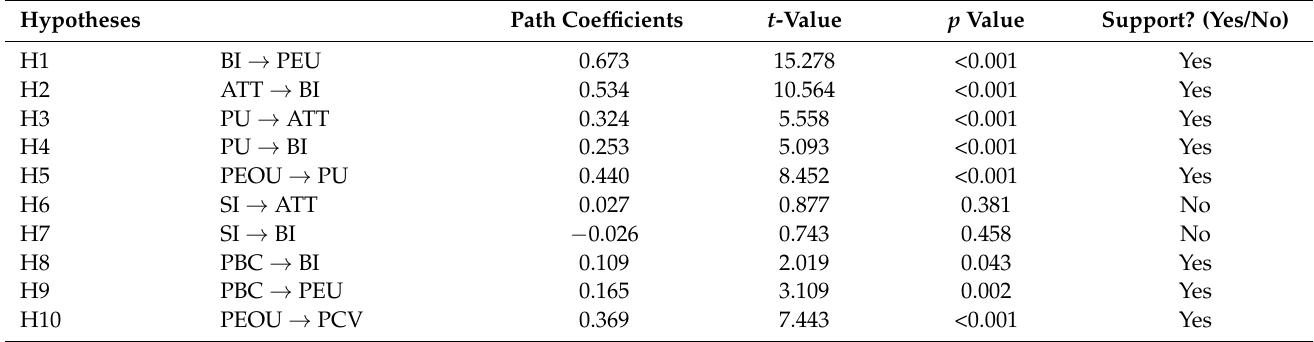
Figure 2. The results of the structural model (note: * p < 0.05; ** p < 0.01; *** p < 0.001). Table 7. Results of hypothesis testing using 5000 bootstrap subsamples.